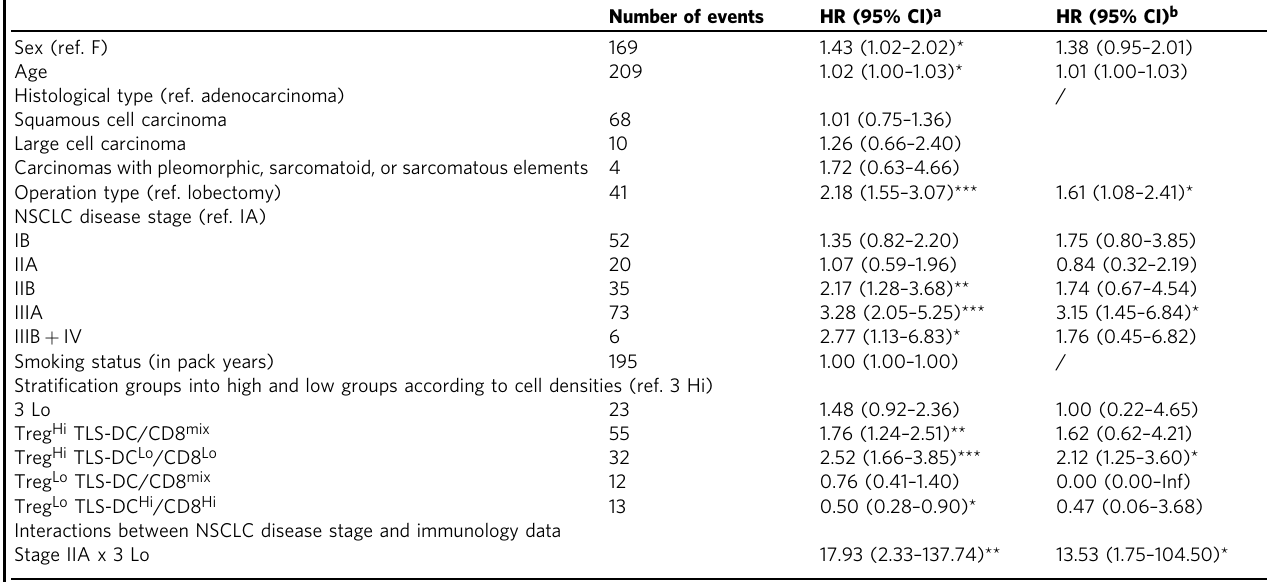
Table 1 Hazard ratio (HR) and 95% Con fi dence Interval (95%CI) for overall survival of NSCLC patients ( n =